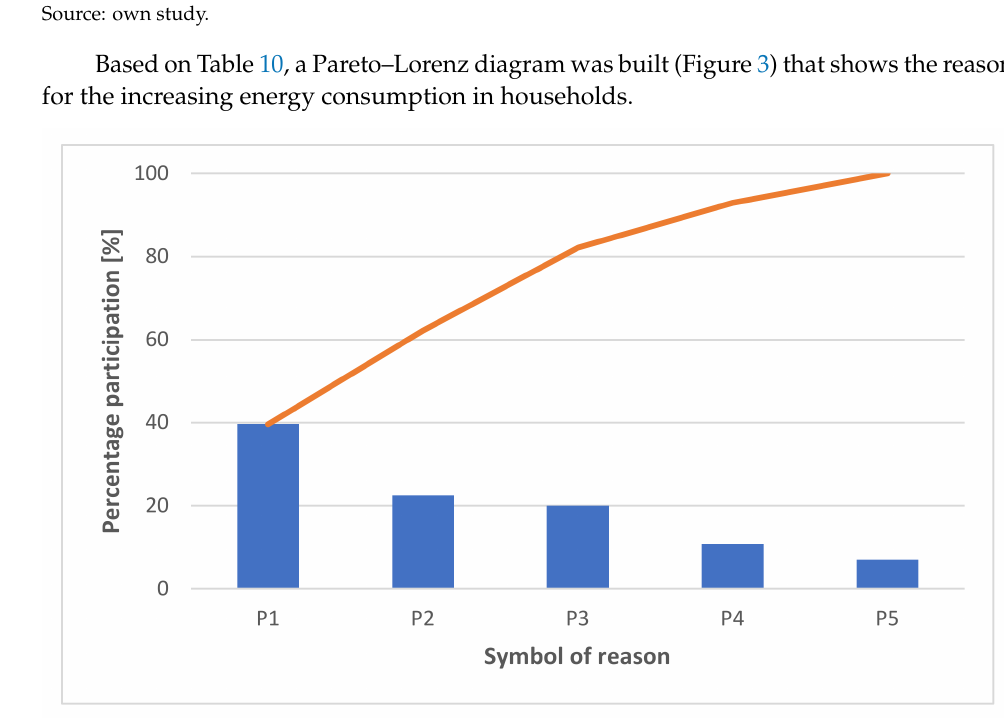
Figure 3. Pareto–Lorenz diagram causes of increasing energy consumption in